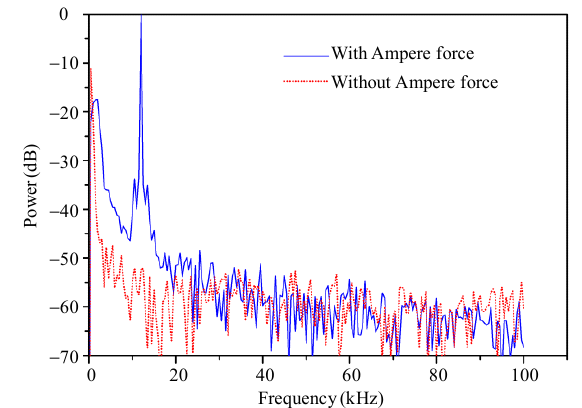
Fig. 7 Comparison of the spectrum with and without signal due to Ampere